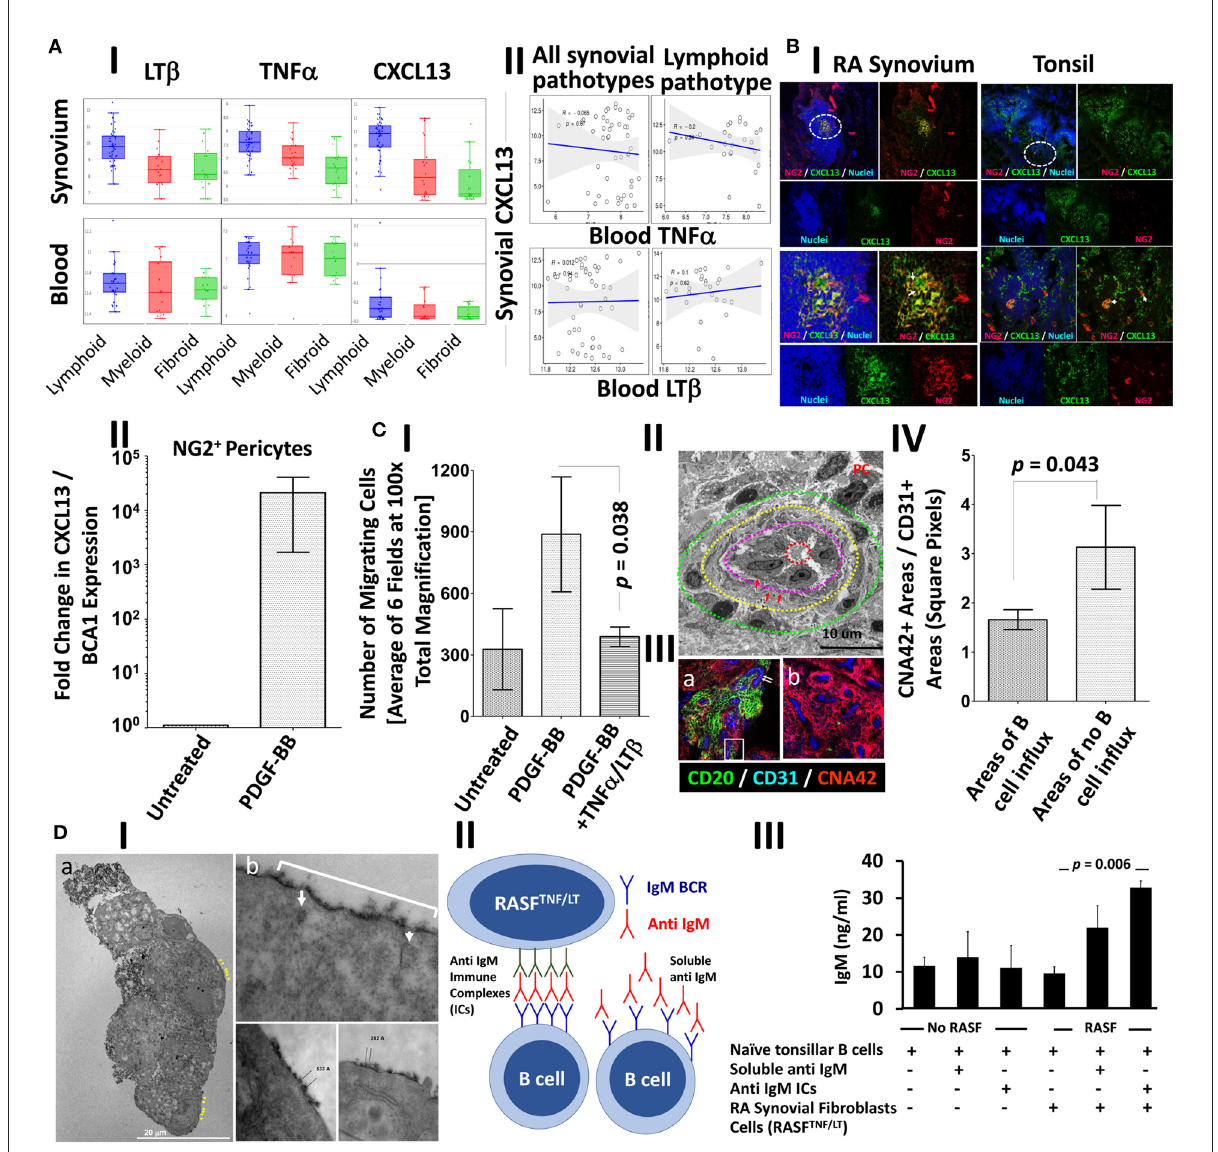
FIGURE5 PDGF-BB-induces pericyte-CXCL13 secretion and RASF migration; and TNF- α /LT- β -activated RASF trap ICs and induce B cell activation. (A) RNA-Seq analysis of the PEAC cohort demonstrating the correlation of synovial and blood TNF- α , LT- β , and CXCL13 in the different RA synovial pathotypes (A-I) , and the correlation of synovial CXCL13 with serum TNF- α and LT- β in the synovial pathotypes in general and the lymphoid pathotype in specific (A-II) . (B-I) Immunohistochemical colocalization of CXCL13 (green) with NG2 + pericytes (red) [nuclei are stained blue] in the RA synovium and tonsils. Single, dual, and triple overlays are presented, and the areas surrounded by white circles are shown at higher magnification in the lower panel. (B-II) NG2 + pericytes were treated with 300ng/ml PDGF-BB and the fold change in CXCL13 gene expression compared to untreated cells was calculated by Livak’s DD equation and shown in bar graph. (C) Stromal/endothelial dissociation at the sites of B cell influx into the rheumatoid synovium. (C-I) The effect of PDGF-BB and TNF- α /LT- β on the trans well migration of RASF. Image J was used to process, segment, and automatically count the number of migrating RASF in 100 × magnified fields after treatment with PDGF-BB with and without TNF- α /LT- β . The averages were calculated and displayed ± the SEM. (C-II) Transmission electron micrograph of the RA synovial HEVs showing concentric zones of the vascular lumen (dashed red circle), high cuboidal vascular lining (zone between the red and magenta dashed circles), multi-layered basement membrane (zone between the magenta and yellow dashed circles, red arrows), and zone showing mural cell displacement (between the yellow and green dashed circles). Plasma cell (PC) with cartwheel nucleus is seen adjacent to the HEV. (C-III) Immunohistochemical analysis showing the proportion of perivascular CNA.42 immature FDCs (red) to vascular CD31 (blue) at sites associated with (a) or devoid from (b) CD20 + B cells (green). The CD31 + endothelium in (a) is relatively of high phenotype [white arrows], and the white rectangle shows B cells insinuated between the endothelium and the CNA.42 + perivascular early FDCs. (C-IV) Image J quantification of the CNA.42 to CD31 ratio at the sites of B cell influx and no influx. (D) Induction of Ig secretion in in vitro GCRs supported by IC-loaded TNF- α /LT- β -stimulated RASF. (D-I) Transmission electron micrograph of HRP-loaded TNF- α /LT- β -stimulated RASF. The ultra-thin sections